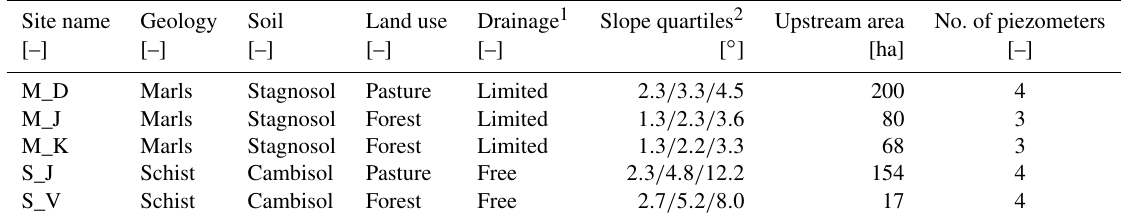
Table 1. The basic attributes of the monitoring sites.